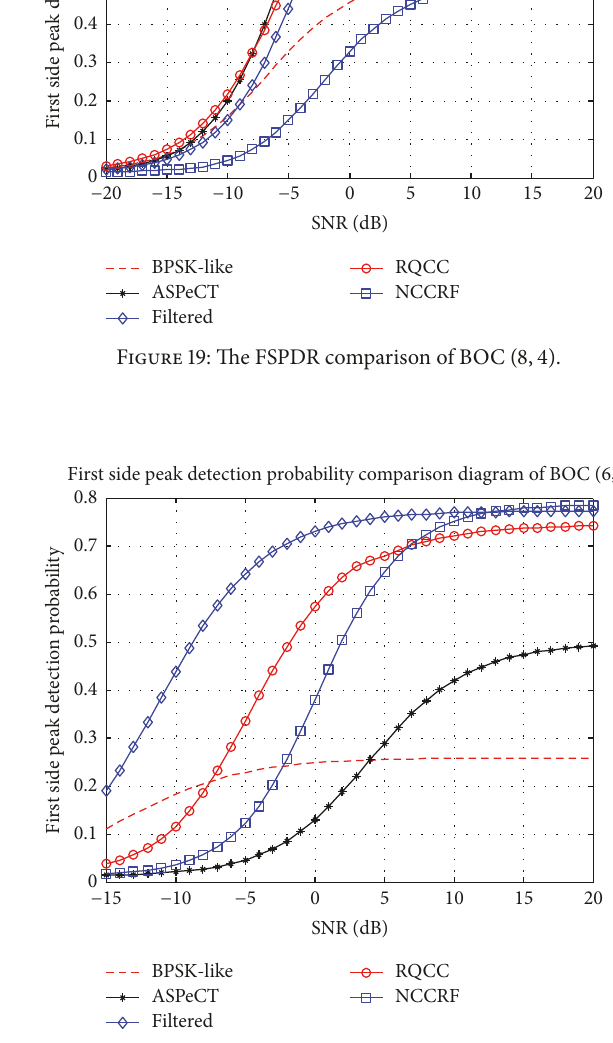
Figure 20: The FblackSPDR comparison of BOC ( 6,1